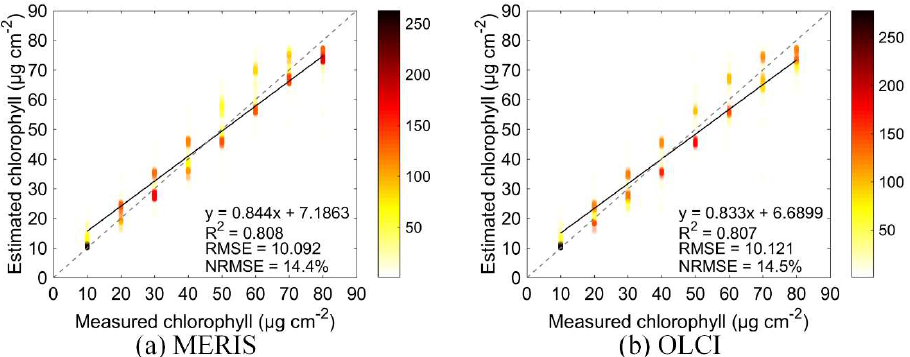
Figure 6. LCC retrieval performance using the LUT approach with the simulated dataset for: ( a ) MERIS; and ( b ) OLCI. Darker colors indicate higher dot density.